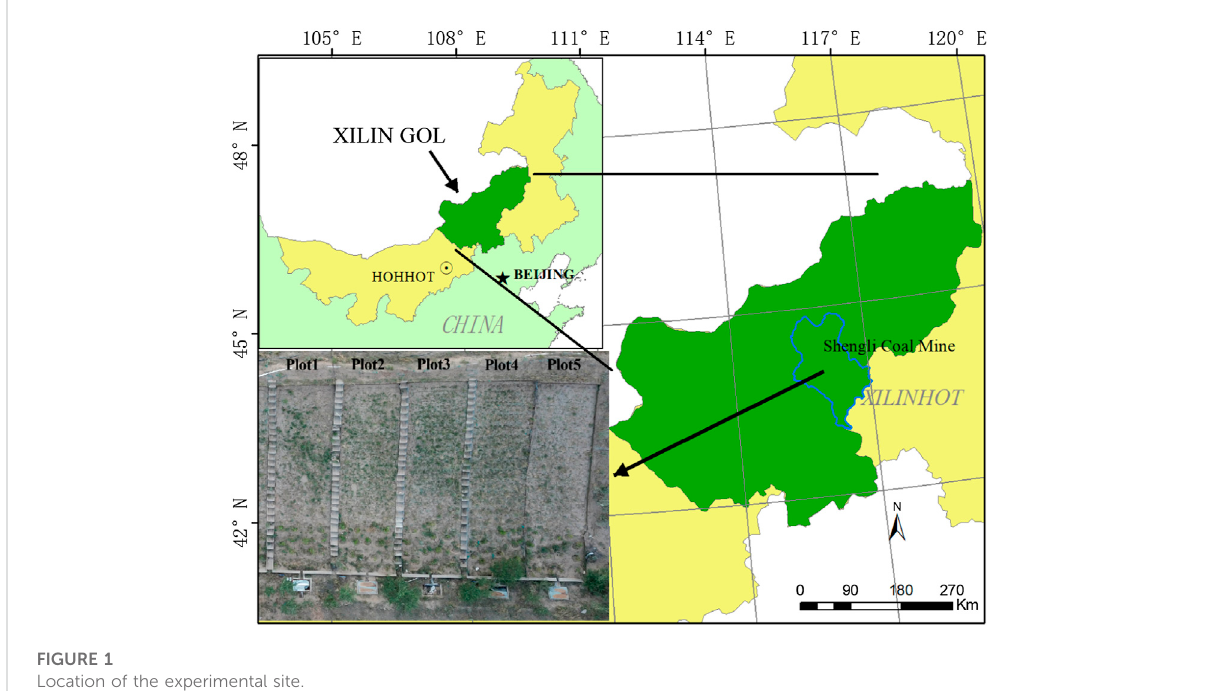
FIGURE 1 Location of the experimental site.